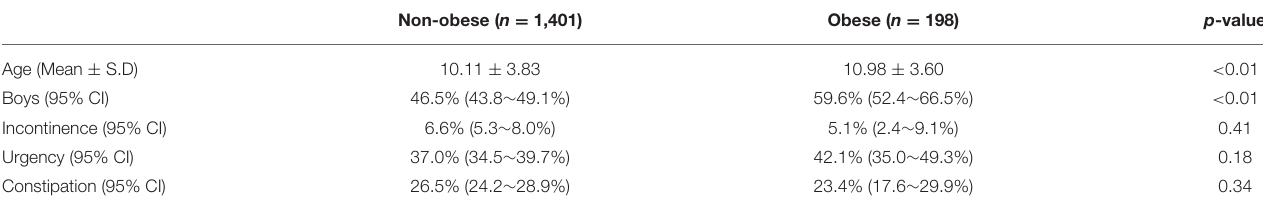
TABLE 2 | Prevalences for incontinence, urgency, and constipation in non-obese and obese